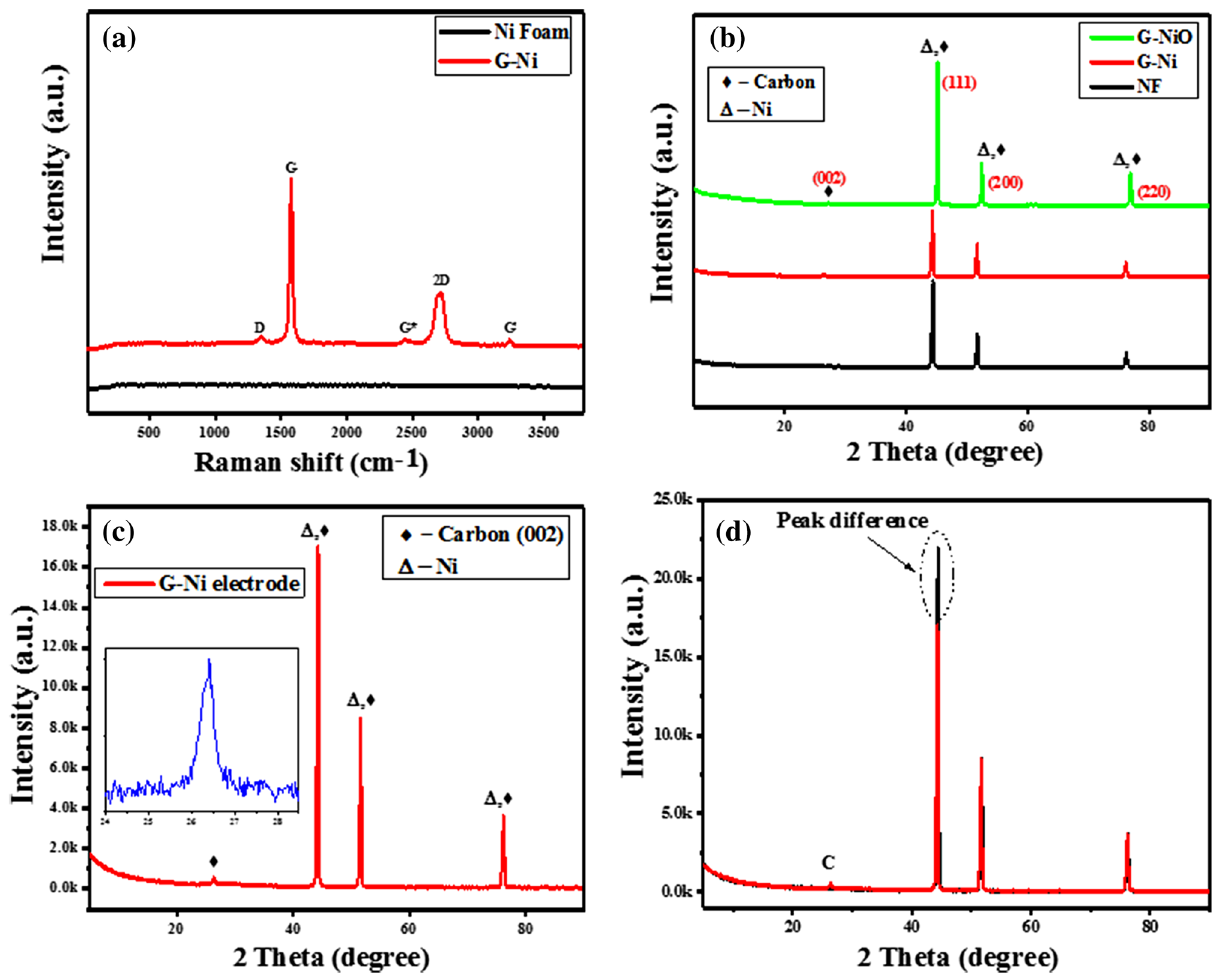
Figure 1. Comparative Raman spectra of ( a ) Ni foam and G-Ni electrode, ( b ) comparative XRD patterns of Ni foam, G-Ni and G-NiO, ( c ) XRD pattern of G-Ni electrode and the inset depicts the expanded peak position of graphene, and ( d ) overlay of the XRD patterns of NF and G-Ni showing the peak